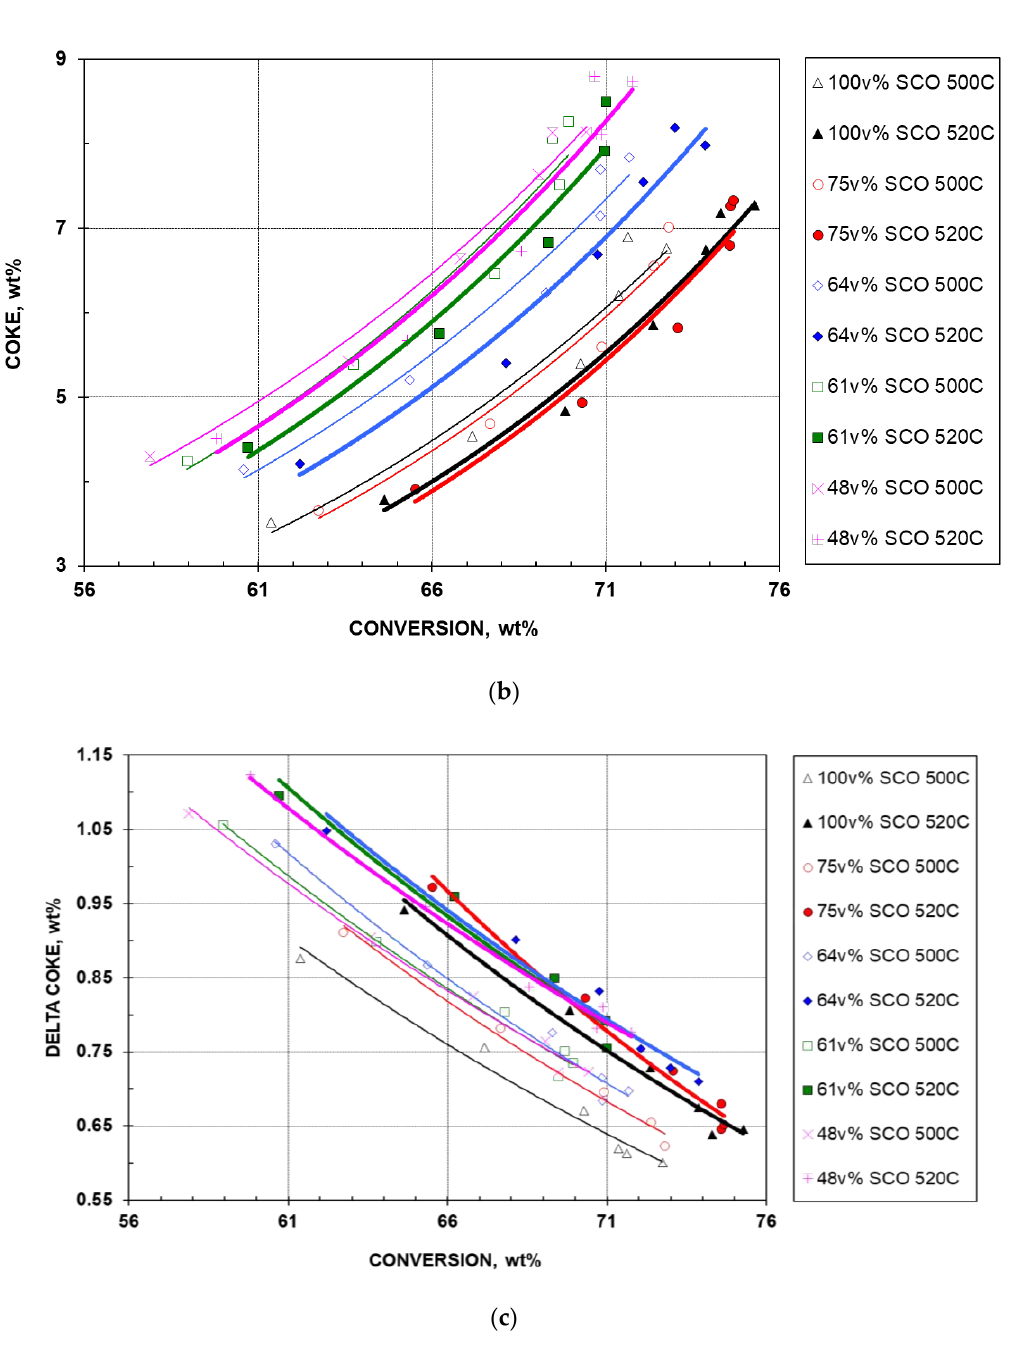
Figure 7. ( a ) Coke yield vs. C/O ratio at two reaction temperatures; ( b ) Coke yield vs. conversion at two reaction temperatures; ( c ) Delta coke vs. conversion at two reaction temperatures.